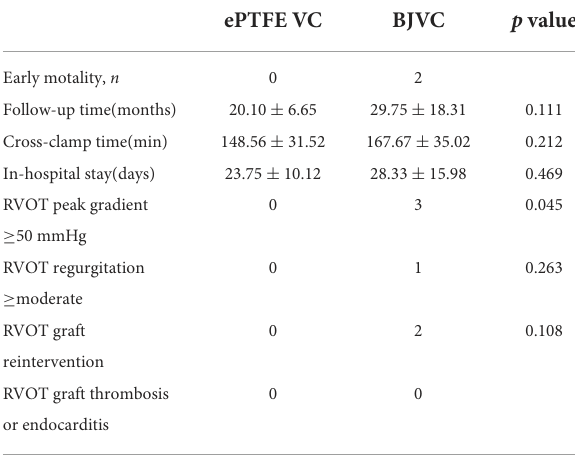
TABLE 2 operative data and follow-up